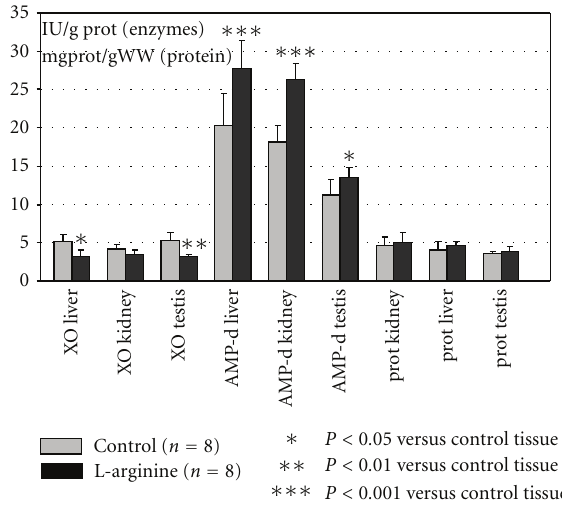
Figure 1: The e ff ect of dietary L-arginine on the activity of 5 (cid:2) - nucleotidase (5 (cid:2) -NU) and adenosine deaminase (ADA) of rat liver, kidney, and testis tissue. The activity of 5 (cid:2) -NU was measured by using 10 mmol/L AMP as substrate, where phosphorus liberation was measured. The activity of ADA was determined by measuring the ammonia liberation by using 4 mmol/L adenosine as substrate. The activity of enzymes was expressed as U/g proteins. Mean values ± SD are given. Each group consisted of 8 animals.